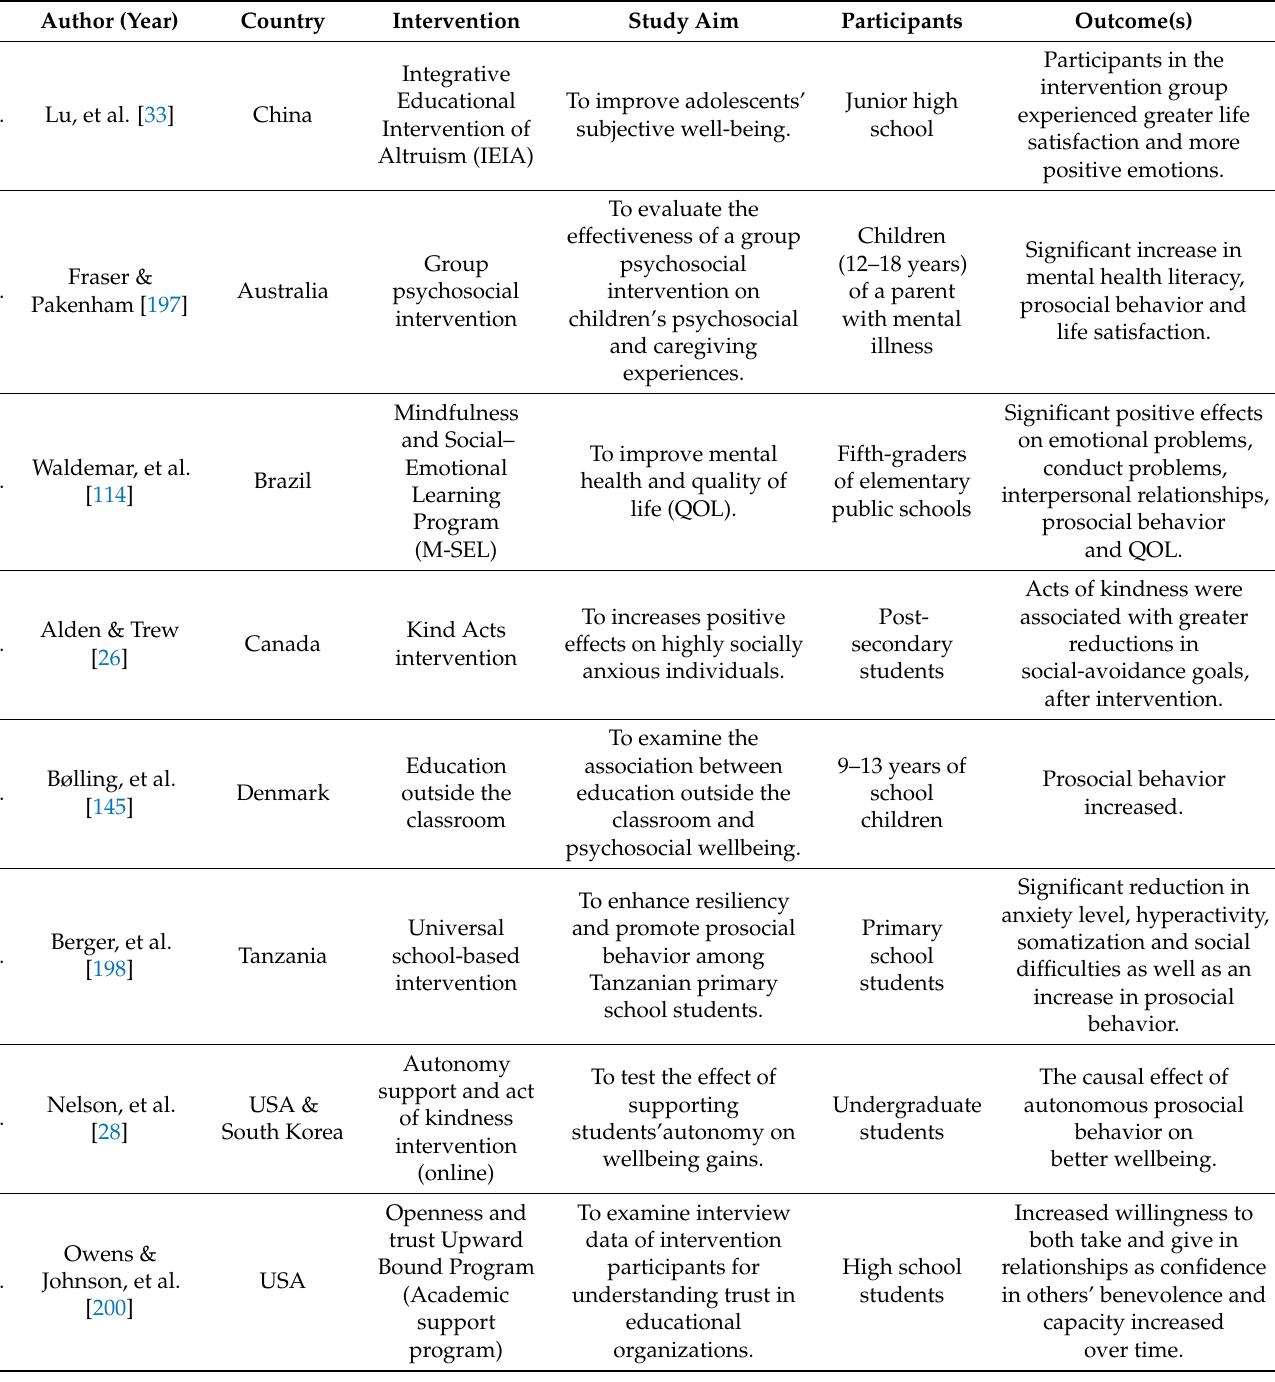
Table 4. Interventions Related to Prosocial Behavior and Youth Mental